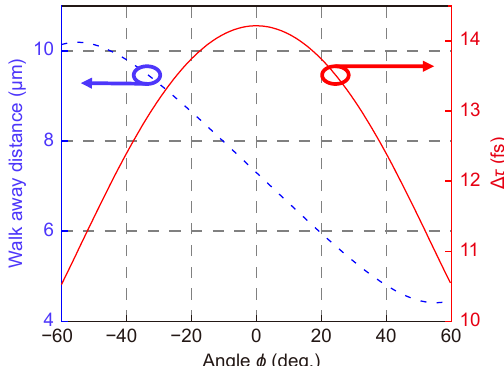
Fig. 6 | Temporal delay (red solid line) and walk-off distance (blue dashed line) between two beams with respect to the tilting angle of α-BBO in the case of